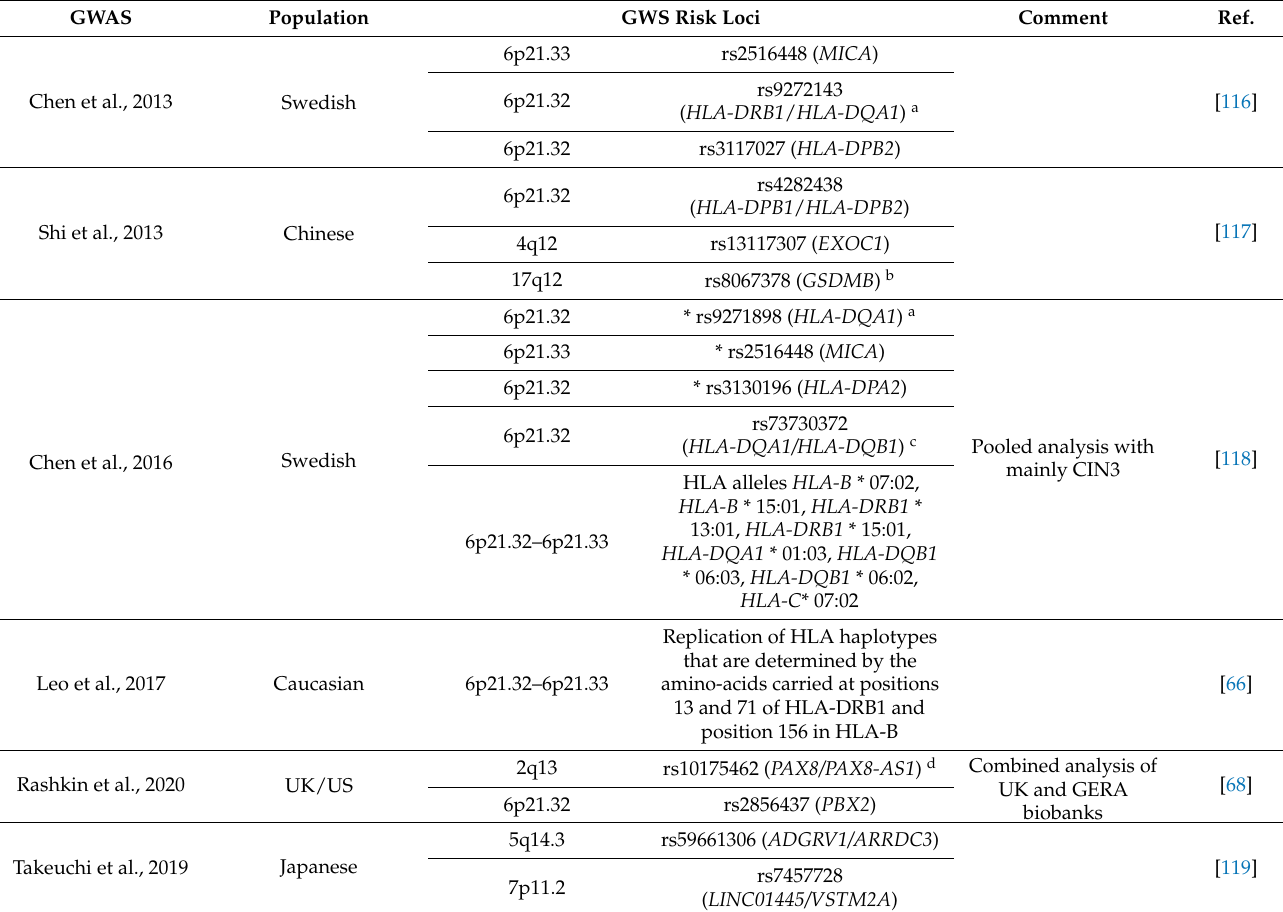
Table 1. List of cervical cancer GWAS performed so far, with study population, genome-wide significant variants, and references. Signals that are correlated at r 2 > 0.3 [110] with other GWAS variants listed above are indicated with a–e. Replication results are indicated with an asterisk (*) before the rsID. LoF: loss of function. GWAS Population GWS Risk Loci Comment